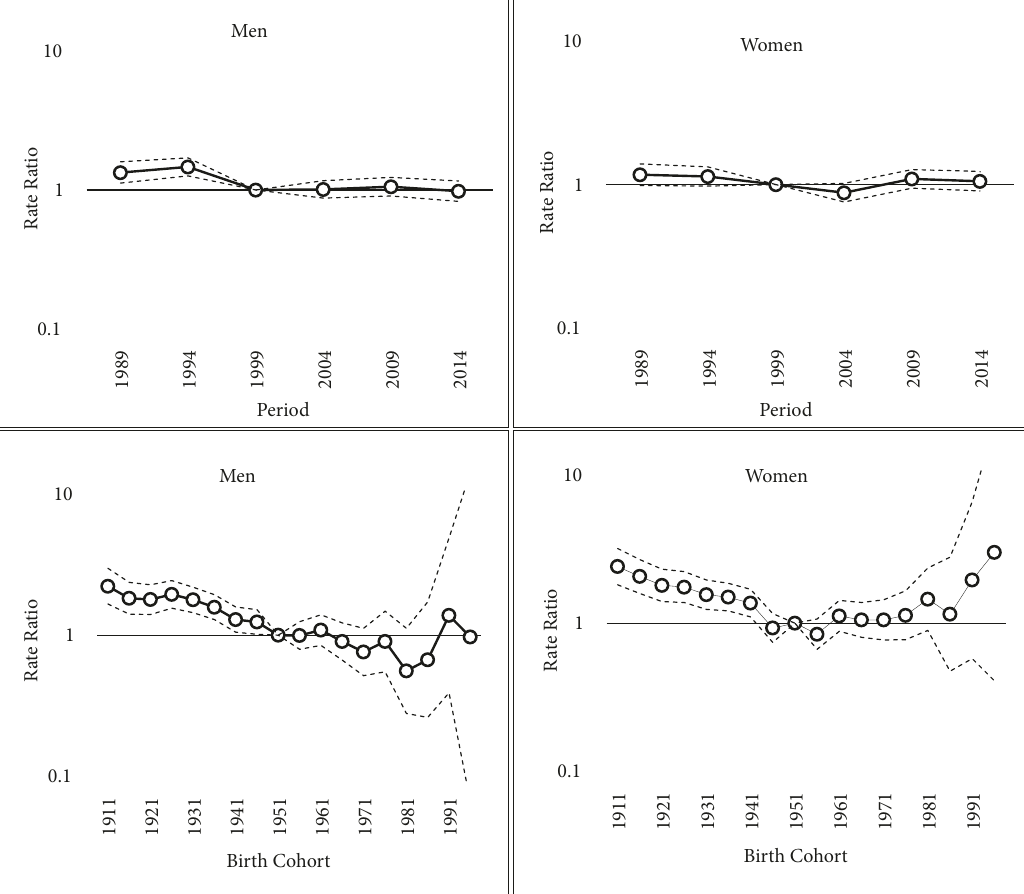
Figure 2: Period and birth cohort effect estimates, with their respective confidence intervals, for the incidence of gastric cancer by sex.